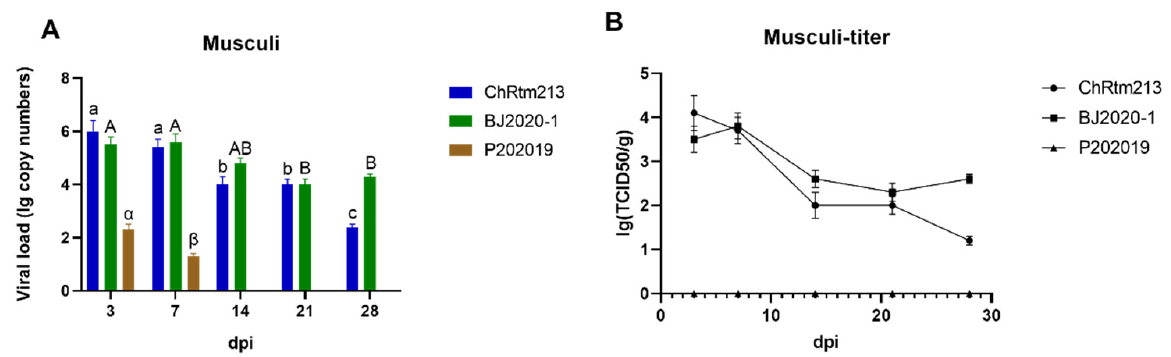
p < 0.05. A, B indicated that the viral load of IPNV- BJ2020-1 was significantly different at different